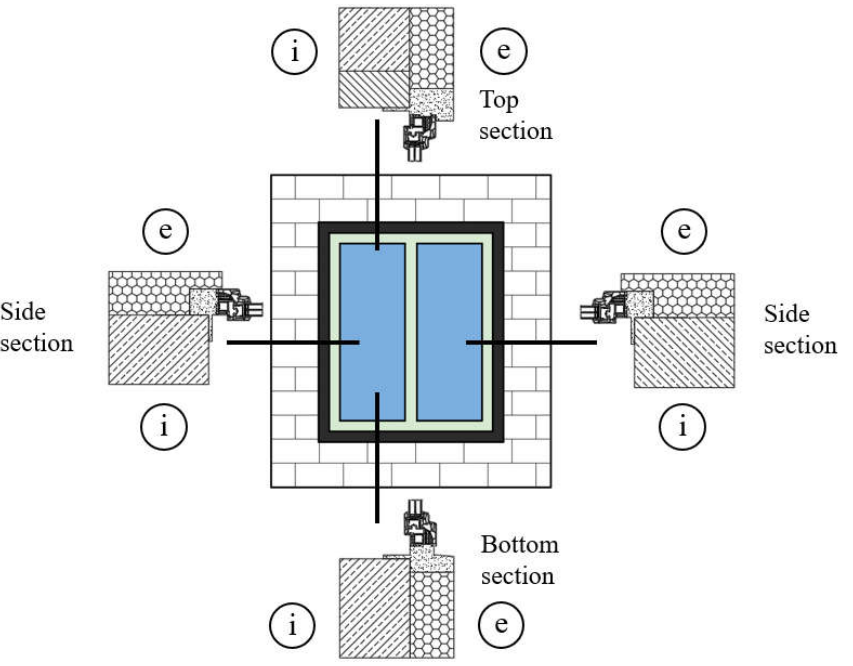
Figure 1. Diagram of analysed sections of the window installation system: i—internal, e—external. Thermal analyses were carried out with TRISCO software [35], based on the finite element method. Some of the numerical calculation results were experimentally verified.